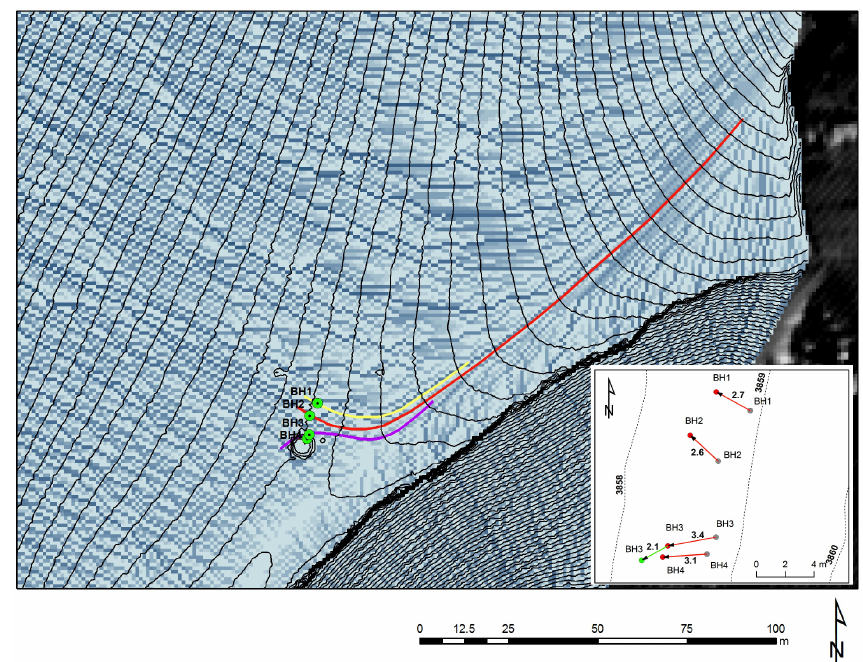
Figure 3. Reconstructed flow lines and borehole displacements over time. The surface topography of the drill site was obtained from a lidar survey conducted during the 2011 campaign (note that the contour lines of the drilling dome are visible). Inset: the displacement between 5 October 2011 and 7 September 2012 is shown in red, while the shift between 7 September 2012 and 1 July 2013 is in green (borehole no. 3 only). The values indicate the displacement (in metres) measured by GPS during these two periods.